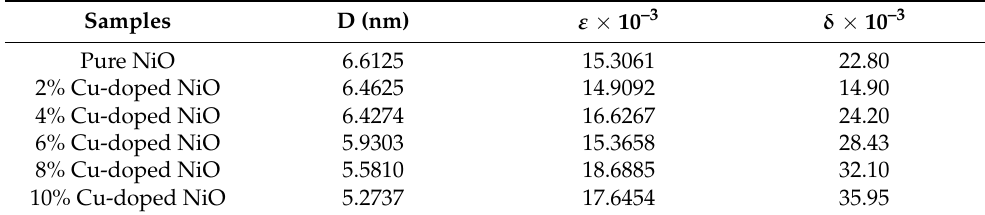
Table 2. Determination of grain size, micro strain and dislocation